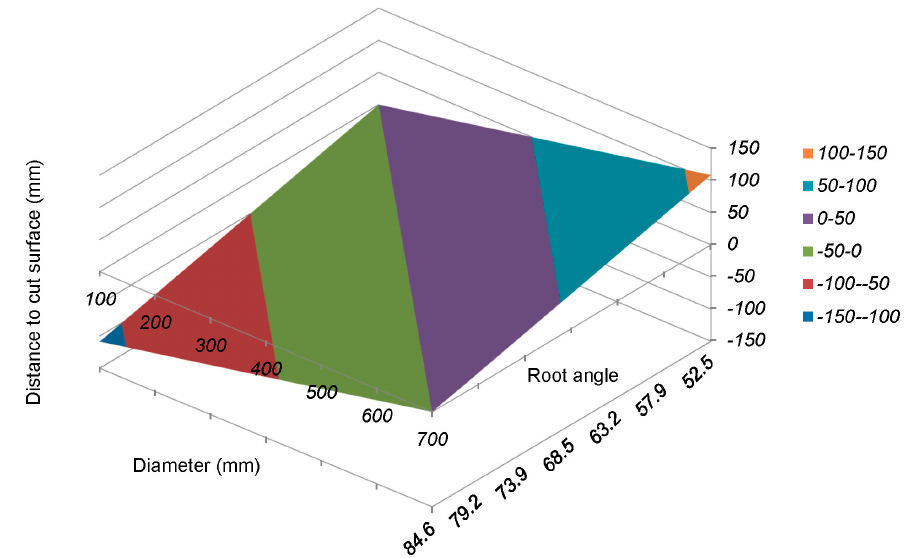
Figure 10. The plane of the 10%-quantile presented in a three-dimensional diagram (stump diameter, root angle, and the distance to cut surface).